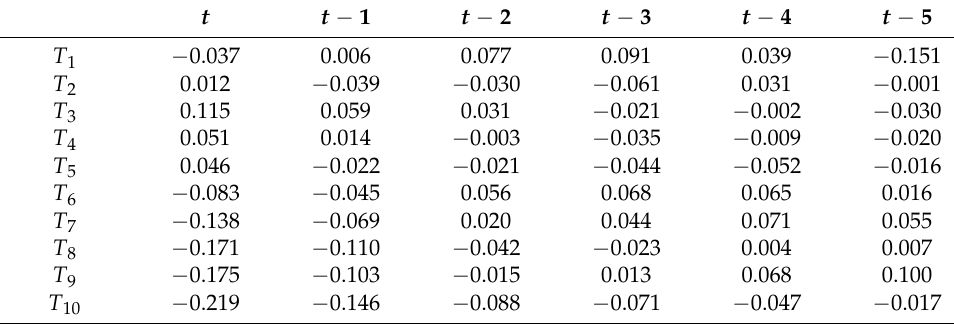
Table A1. Model parameters for top